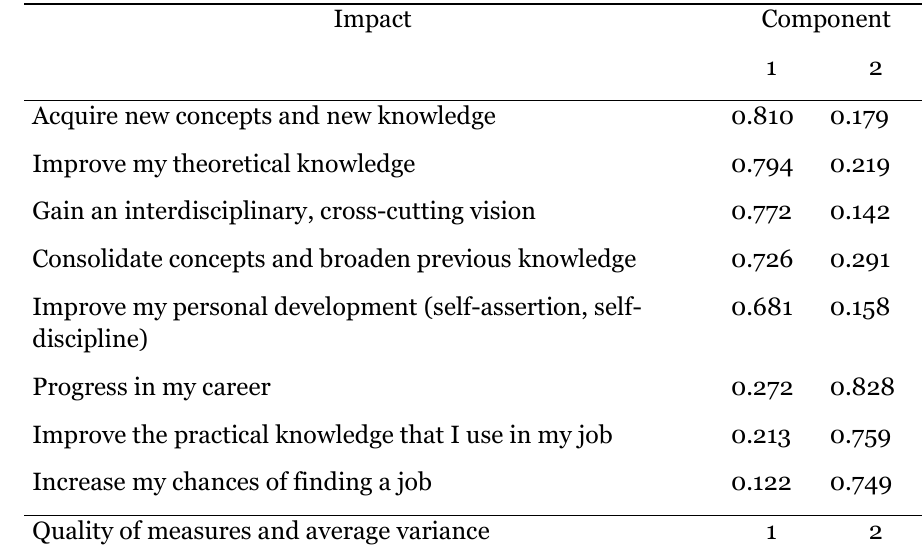
Rotated Component Matrix of the Exploratory Factor